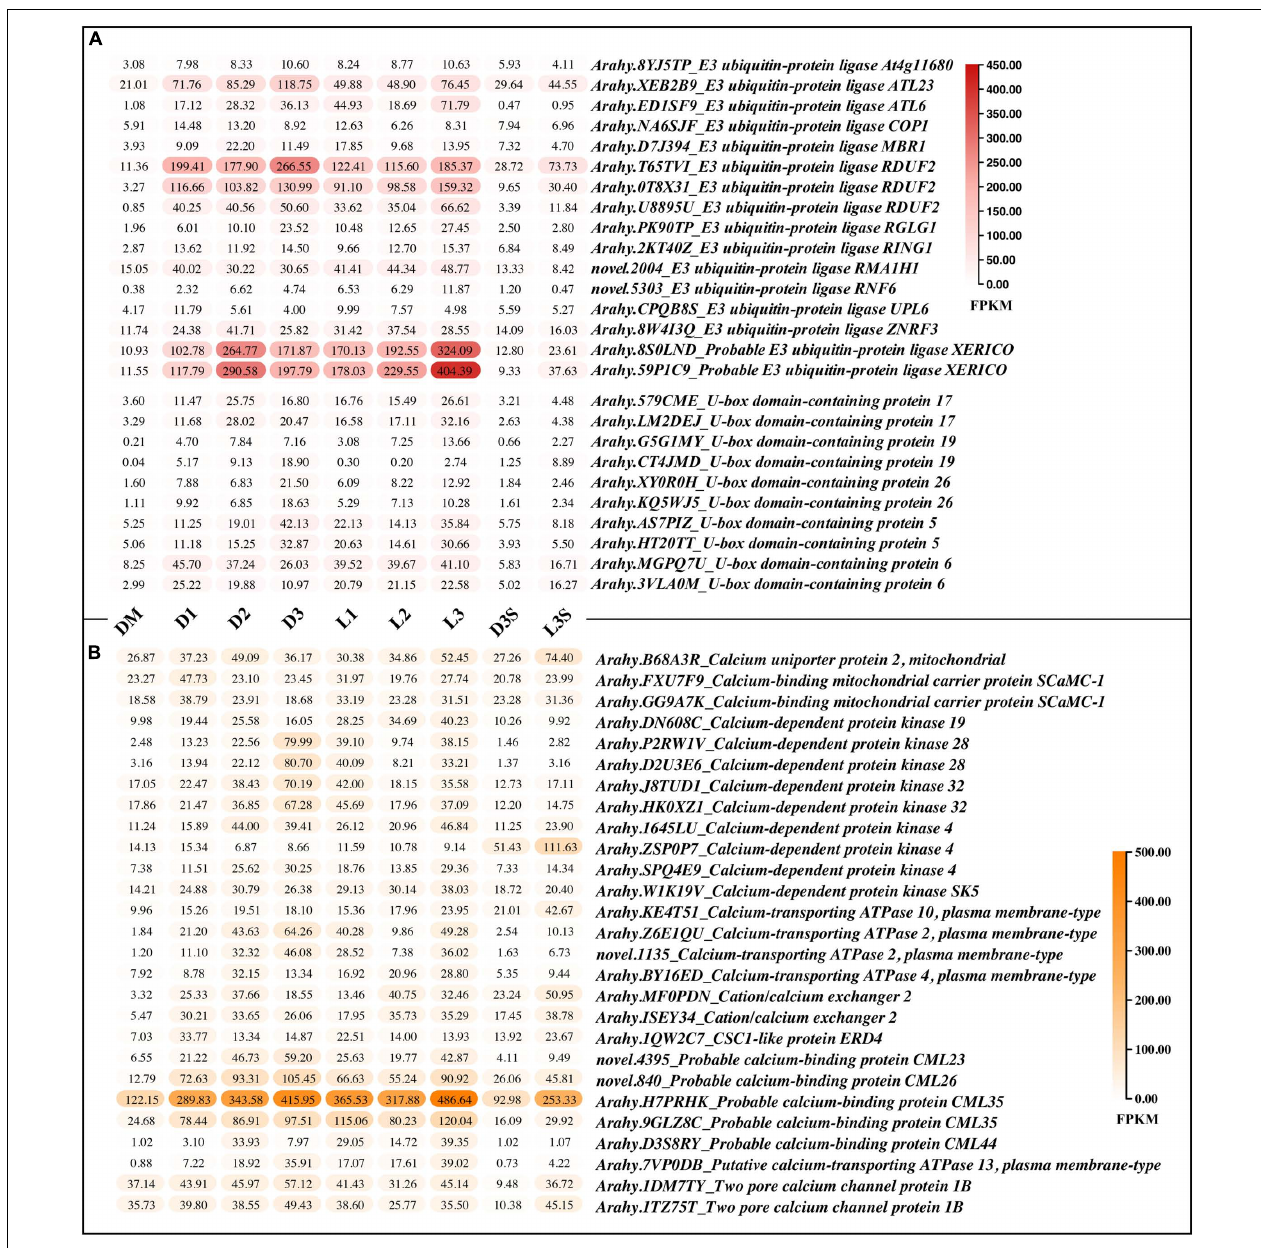
FIGURE 4 | DEGs related to protein ubiquitination and calcium ion binding. (A) DEGs related to protein ubiquitination; (B) DEGs related to calmodulin, only those with FPKM value ≥ 30 in at least one sample are listed; the others can be found in Supplementary Table 8 .